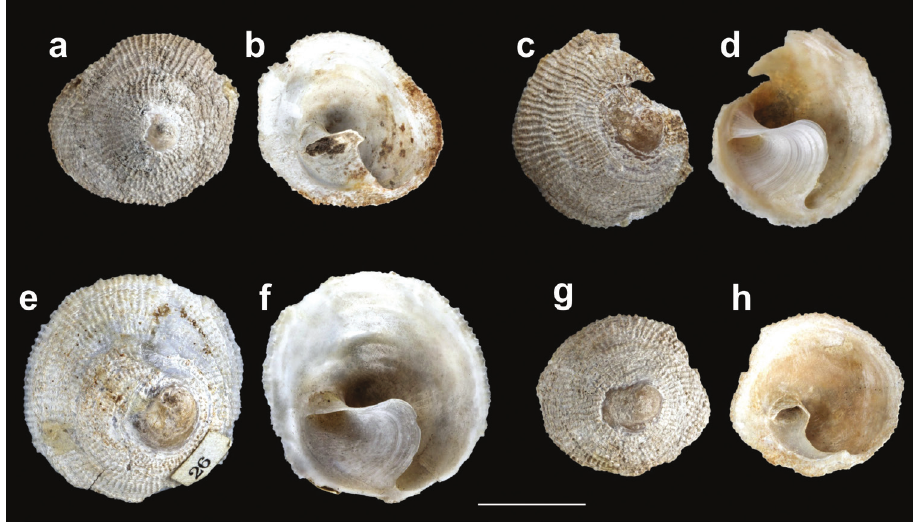
Figure 3. Calyptraea aurita . NHMUK 197798, syntypes of Crucibulum auritum Reeve, 1859. a, c, e, g dorsal view b, d, f, h ventral view. Scale bar: 1